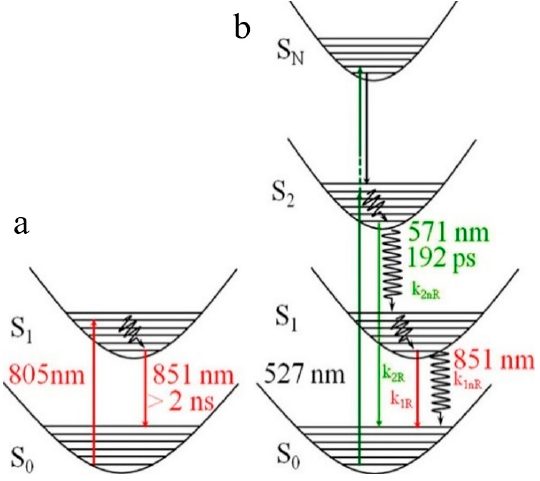
Figure 12. Schematic diagram of excitation of IR125 ( 44 ) in DMSO by ( a ) 805 nm laser pulse (low- energy excitation) and ( b ) 527 nm laser pulse (high-energy excitation). Incident laser polarization dependent studies have shown the importance of higher excited states in the fluorescence emission as discussed in the text. Reprinted from [55], Copyright 2013, with permission from Elsevier.